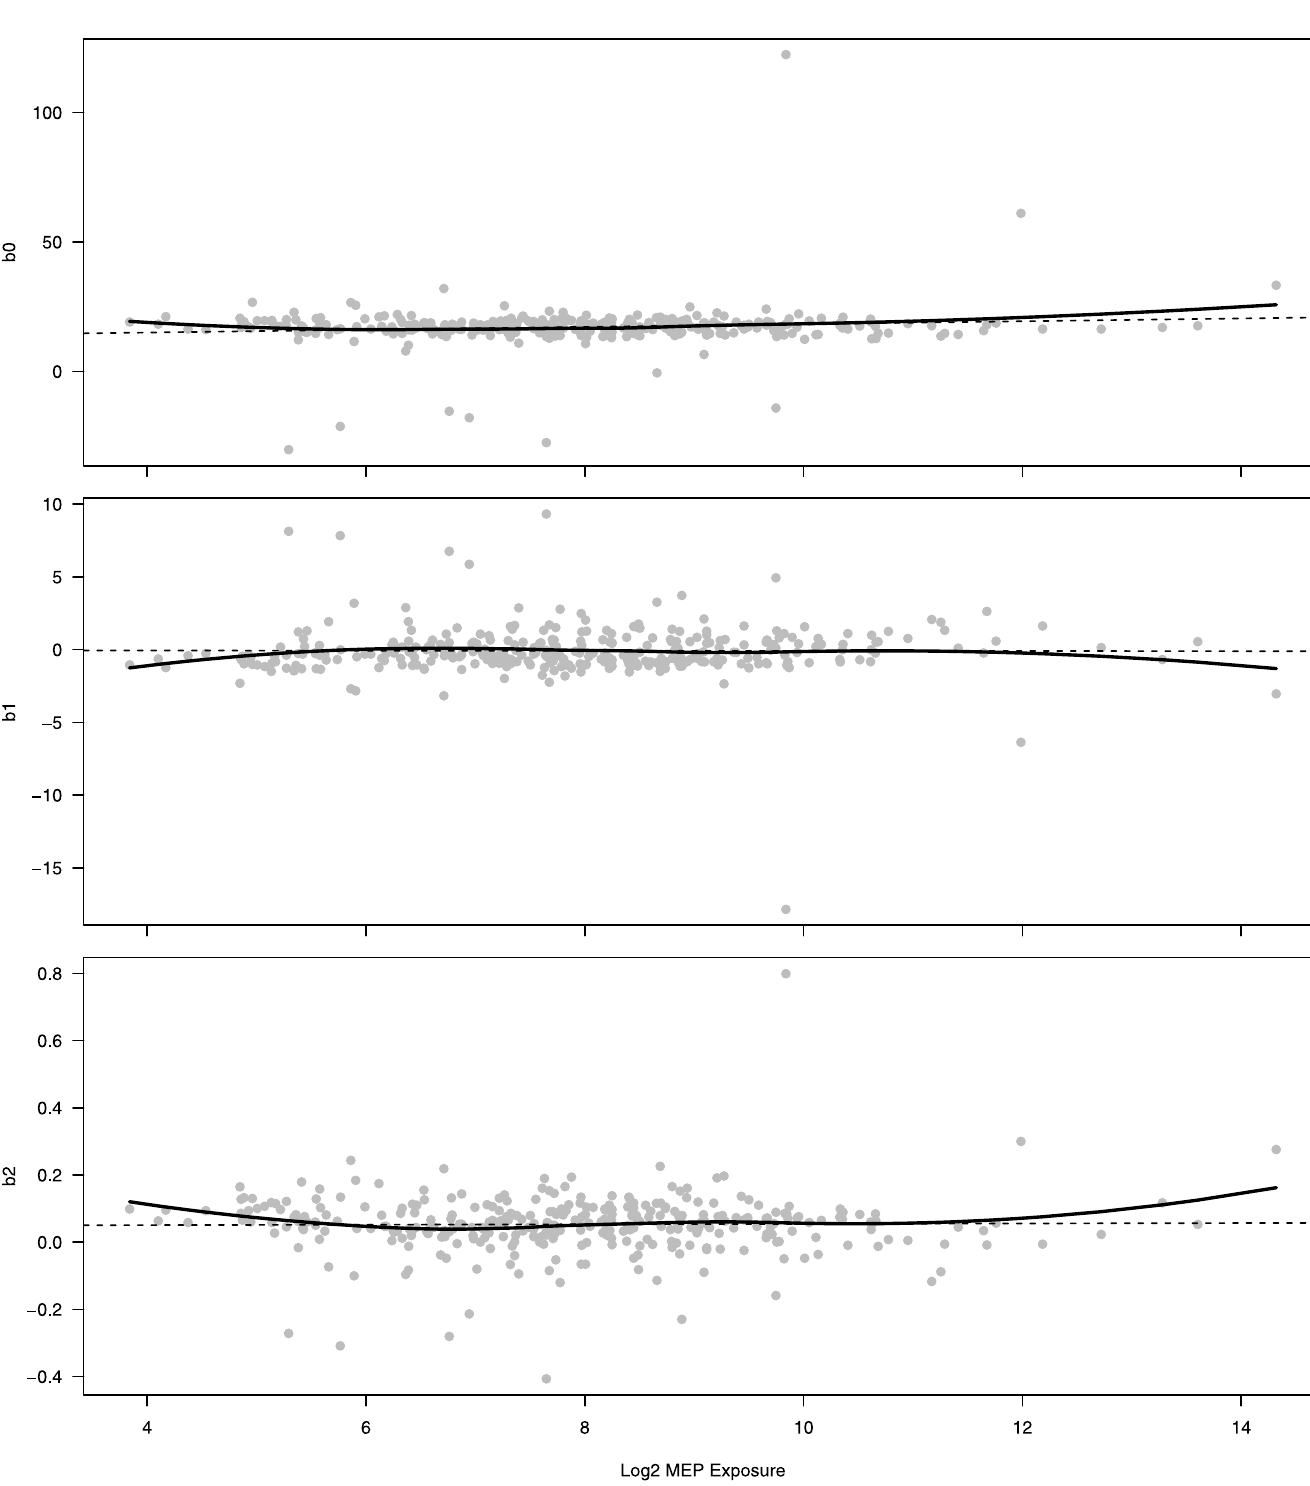
Fig 1. MEP exposure and growth parameters. MEP exposure during pregnancy (x-axis) and estimated growth parameters from individual quadratic model fits (y- axes) for the CHAMACOS data. Dashed line is a least squares line and the thick line is a smooth loess curve.